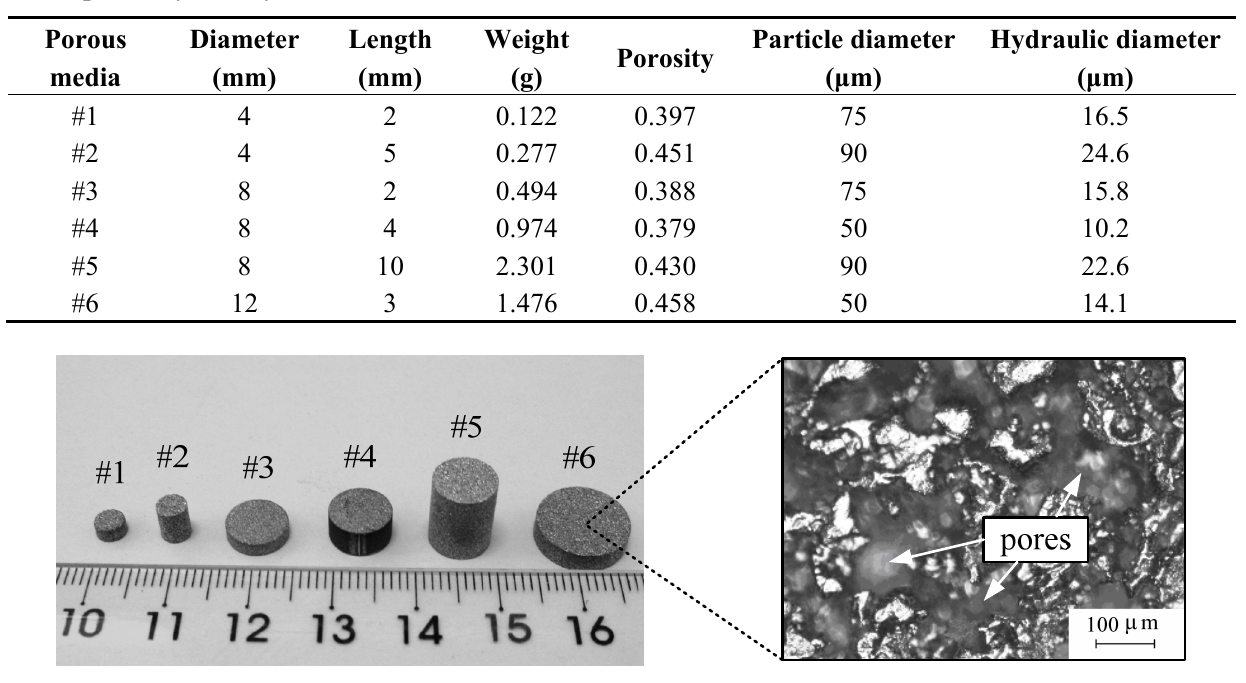
Table 1. Dimensions, weights, porosities, average particle diameters, coefficient of sphericity and hydraulic diameter of the test resistances.